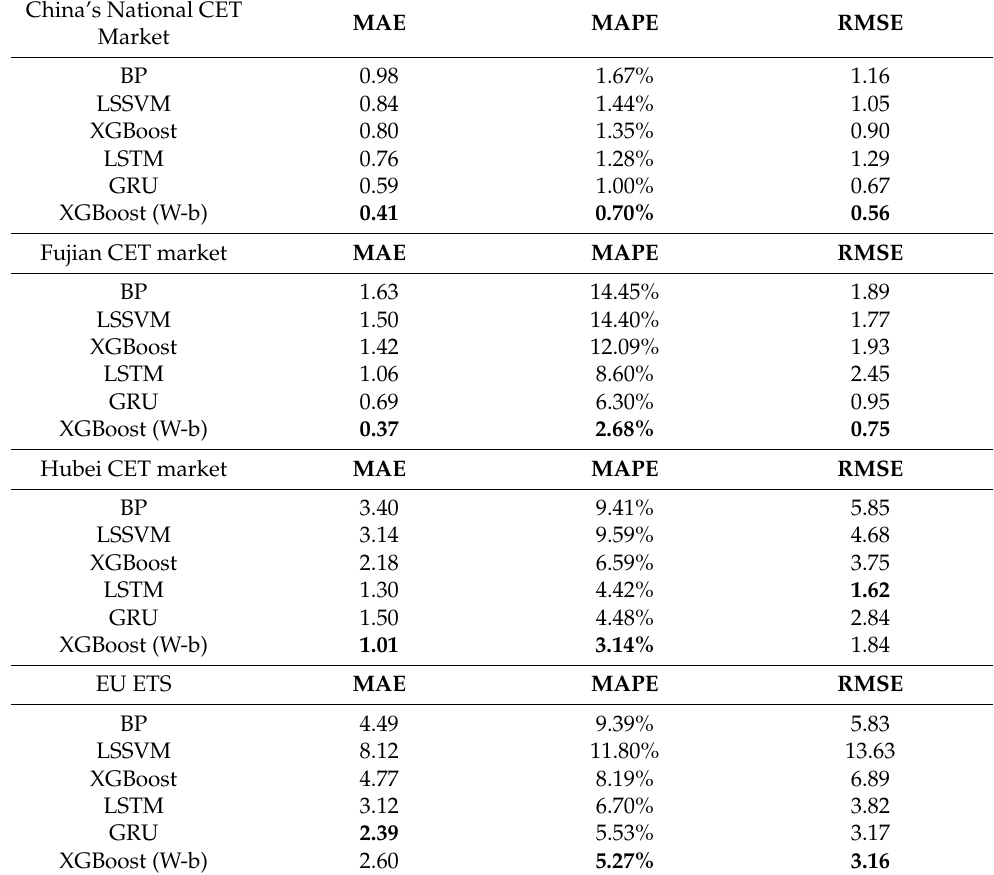
Table 4. The error of the forecasting